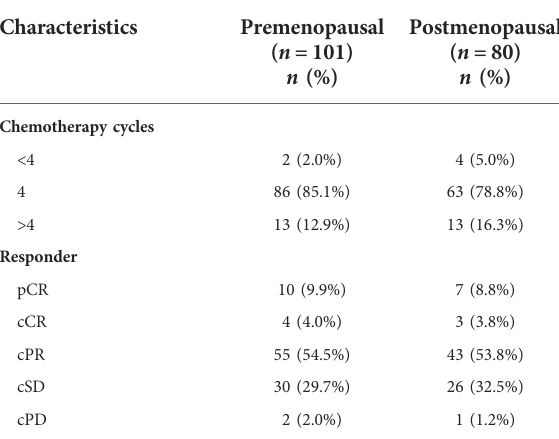
TABLE 1 Baseline clinicopathological characteristics of all